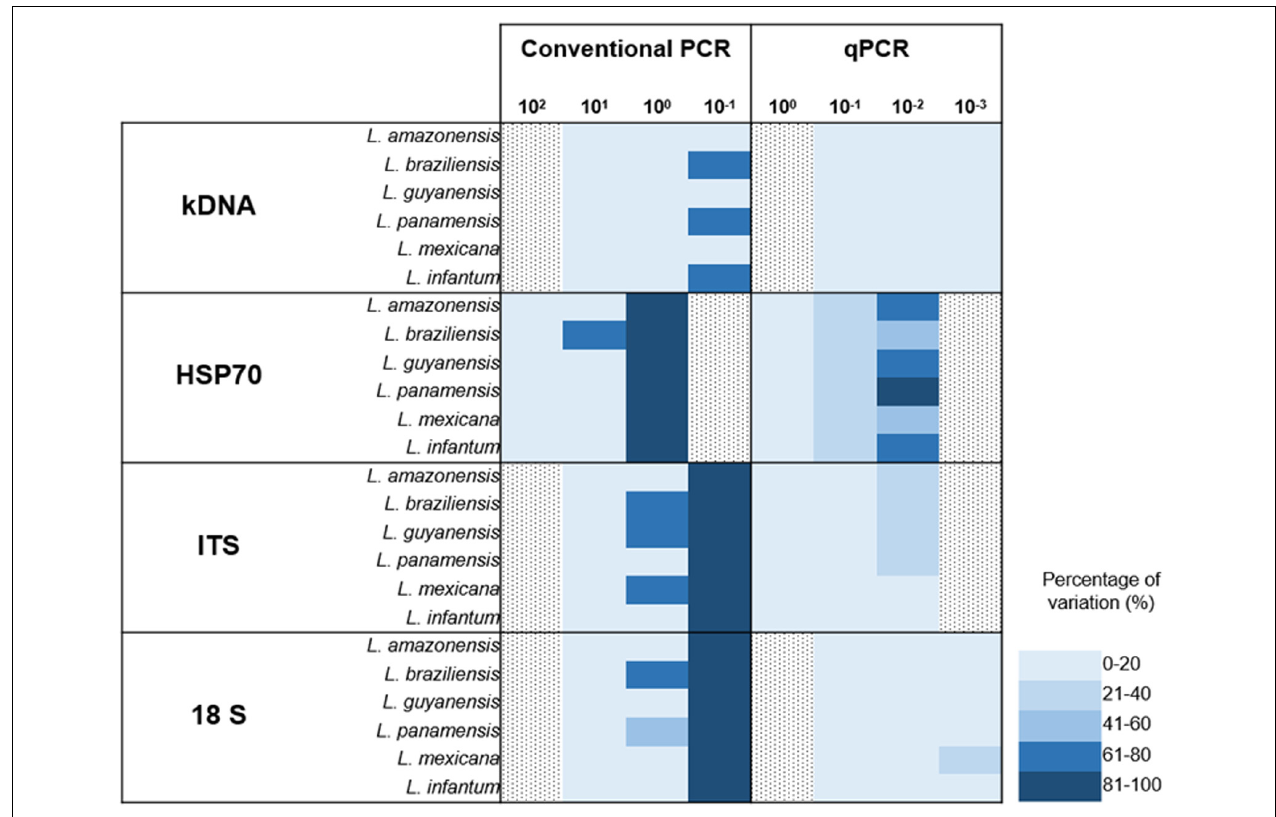
FIGURE 4 | Absolute comparison of percentages of variation in conventional and real time PCR for the four markers employed across the seven species